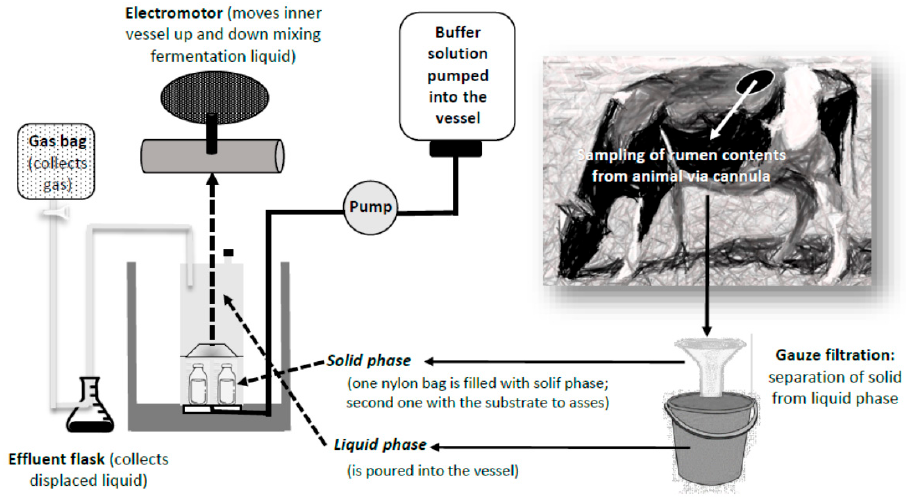
Figure 4. One fermentation vessel of the Rusitec system (adapted from Riede at al., 2006